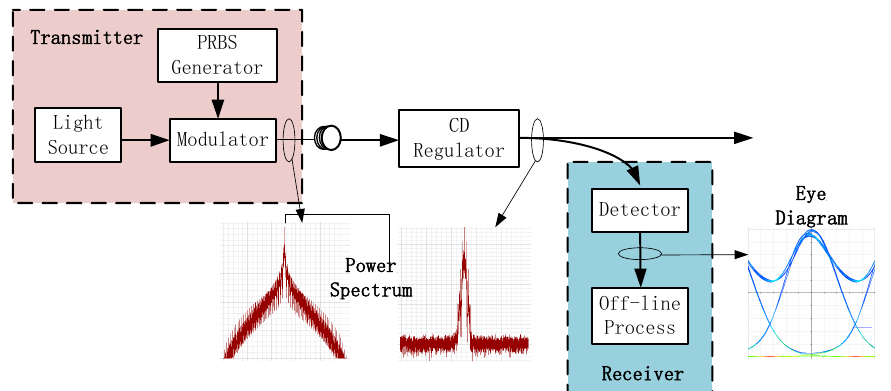
Figure 14. Scheme of dispersion monitoring system for OOK signal .